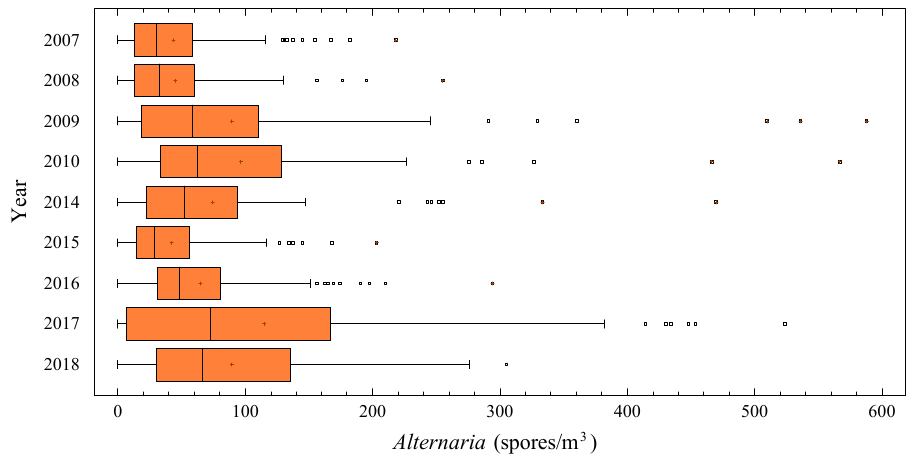
Figure 3. Plot of Alternaria concentration by year recorded during the period of potato crop. The relationships between the daily Alternaria concentration and the meteorological factors (mean, maximum, and minimum temperatures; mean relative humidity; and rain) were analyzed by Spearman correlation analysis. The aerial Alternaria concentrations and meteorological conditions were recorded during the same day and with the previous days considered (Table 2). The presence of conidia of Alternaria in environment during previous days was influenced positively by the concentration of the day ( p < 0.01). The correlation coefficients showed a strong relation of the minimum, mean, and maximum temperature with Alternaria concentration. The temperature (both of the same day and previous days) was positively correlated with the levels of conidia with positive coefficients ( p < 0.01). However, the relative humidity only was positively correlated with Alternaria the 3 and 4 days prior ( p < 0.05). No significant correlation was found between the concentration of Alternaria and rain. Table 2. Number of days and date with interrupted wet periods (IWP) considering the first peak Alternaria and the days with 6 IWP by crop cycle.